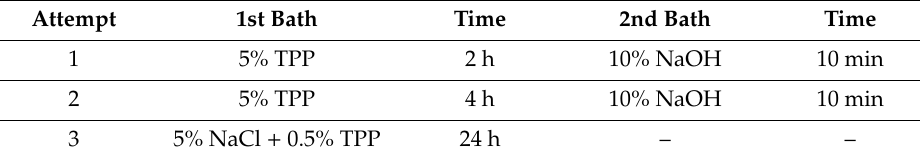
Table 3. Gelling system compositions: in the first two attempts samples were immersed consecutively in two solutions for di ff erent times, in the third gelling solution was just one (TPP—sodium tripolyphosphate).